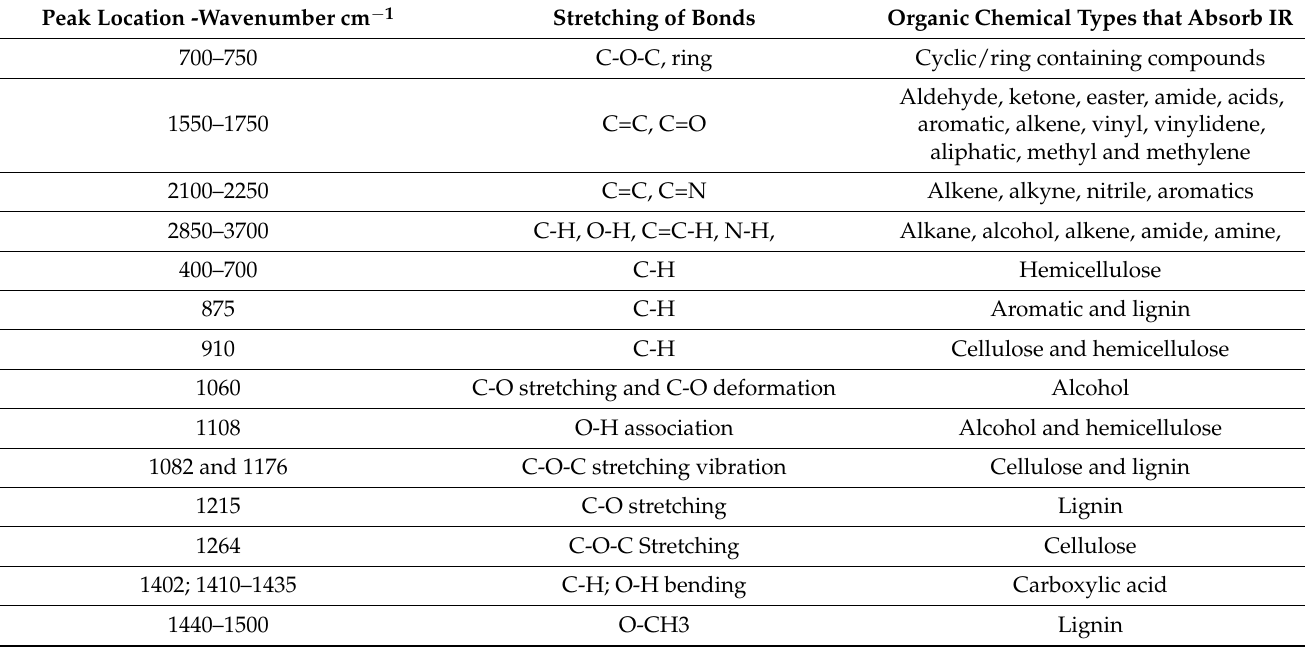
Table 2. Absorbance range and possible functionals providing FTIR